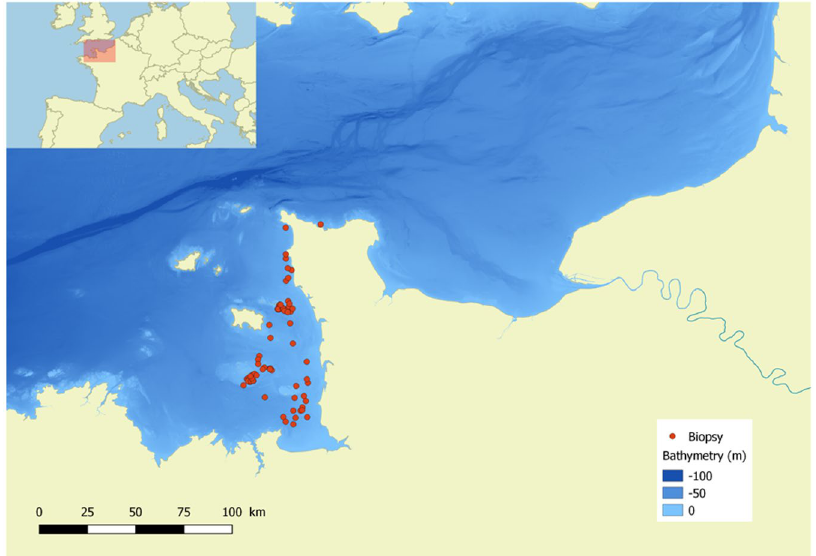
Figure 6. Sampling location of bottlenose dolphins Tursiops truncatus in the Normanno-Breton Gulf (English